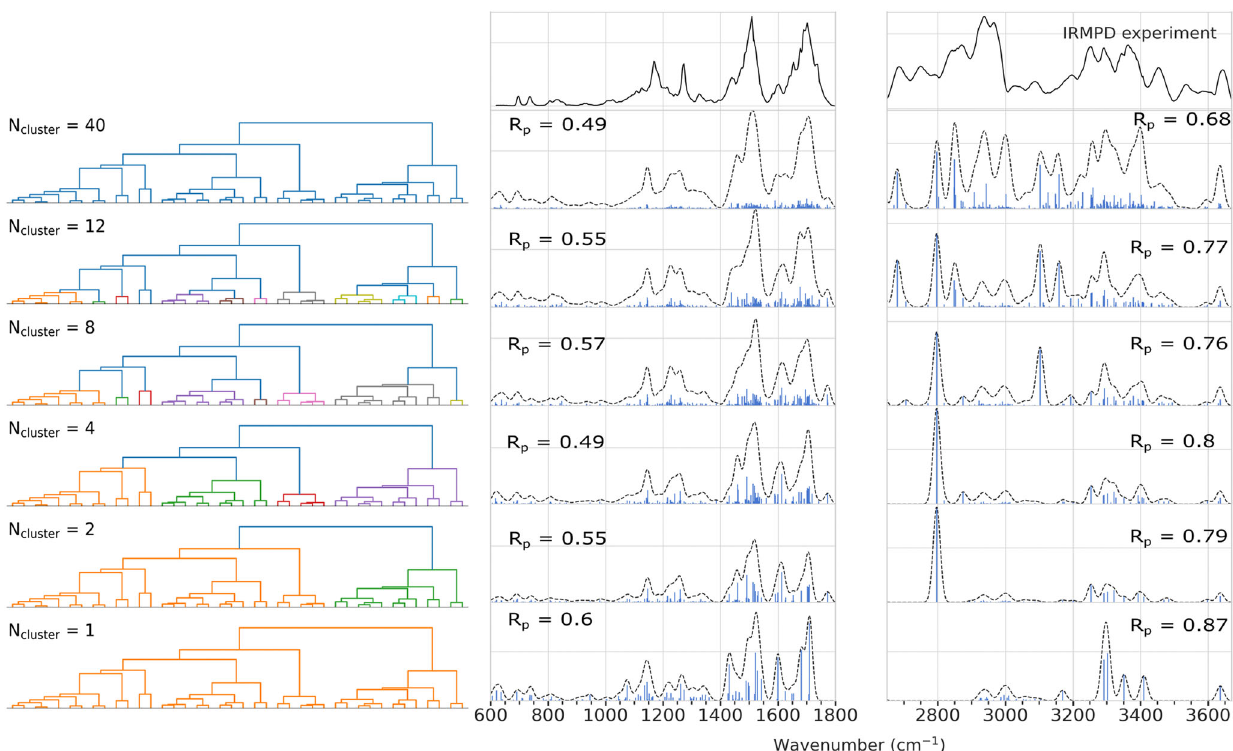
Fig. 5 Average IR spectra for different number of merged PAMM clusters compared to the experimental IRMPD spectra of LeuEnk. Spectra are ordered by the number of PAMM clusters used and merged hierarchically as indicated by the dendrograms in the left panel. The top panel shows the spectrum considering all conformer clusters, while the bottom shows the spectrum of a single merged conformer cluster. Reliability factors R P are reported individually for both amide A/B (middle) and amide I/II/III/V (right)